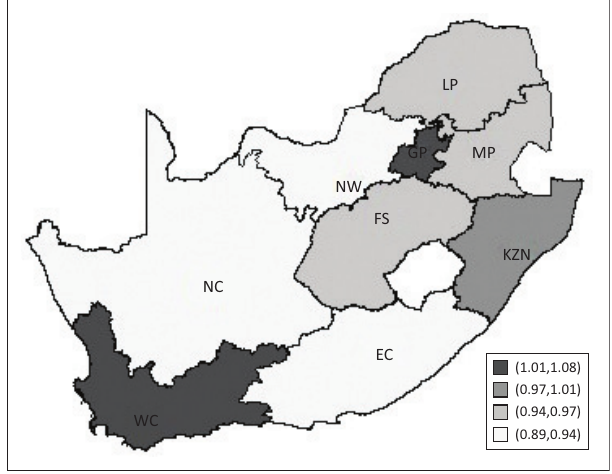
Note: The figure shows financial literacy scores by occupation, income and source of money. The data is weighted to be nationally representative, with weights benchmarked against Statistics South Africa weights. FIGURE 2: Financial literacy by occupation, income, and source of money.